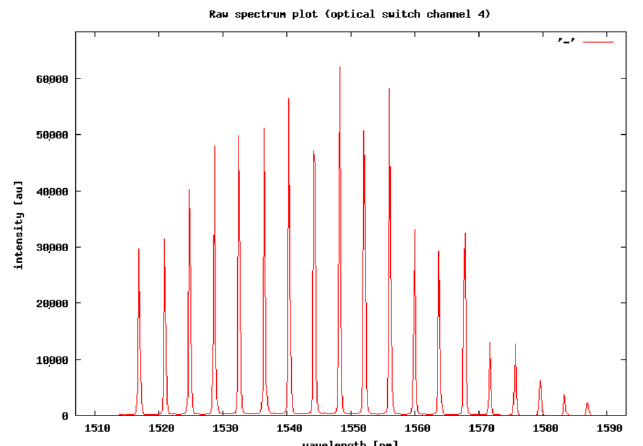
Figure 4. Time sample of the reflected optical spectrum from the FBG array received by the interrogator.